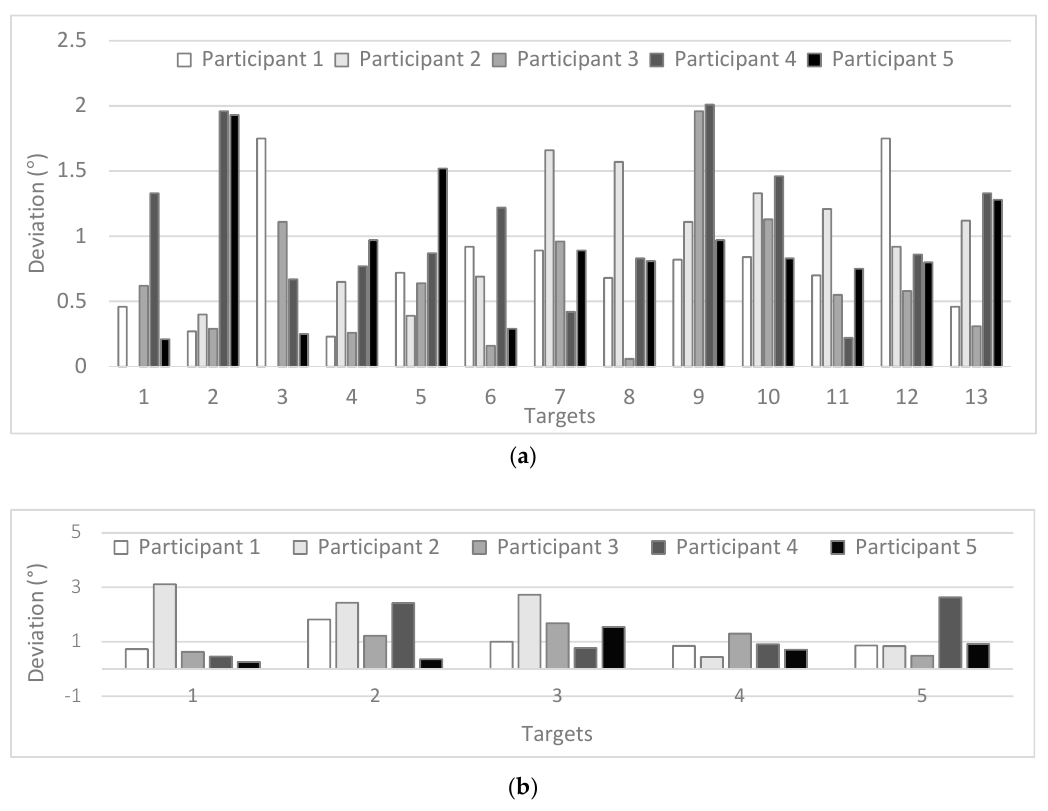
Figure 11. Deviations (visual angle) for the case of threshold 1.0° for 13 targets ( a ) and 5 targets ( b ) for all participants.